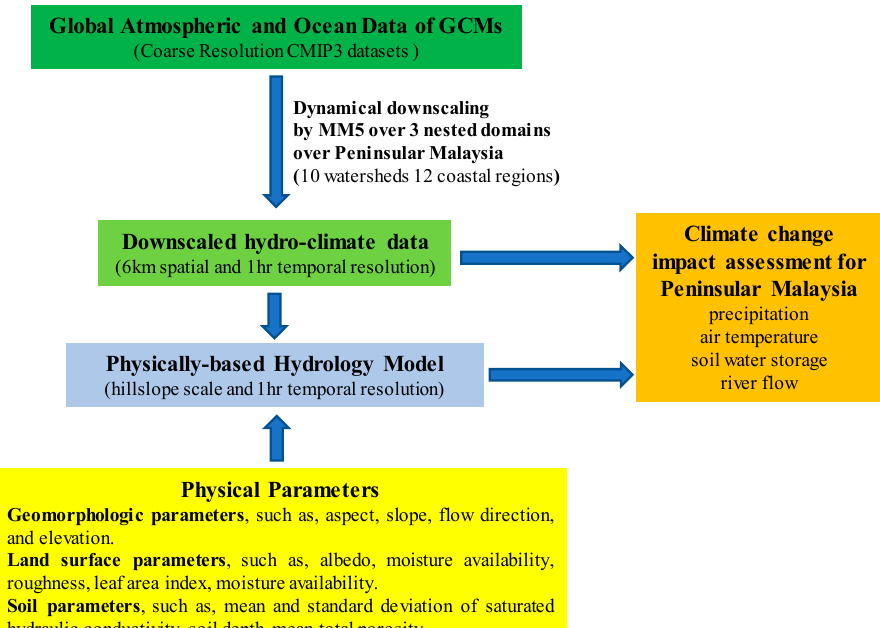
Figure 2. Schematic description of the modeling approach.